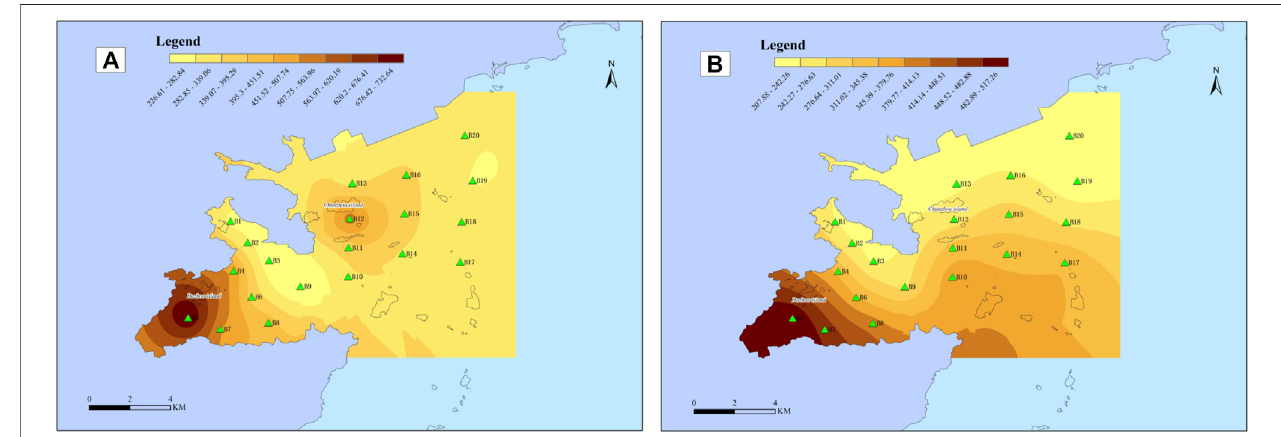
FIGURE 6 | The potential ecological risk index ( RI ) of heavy metals in surface sediments during spring (A) and autumn (B) .